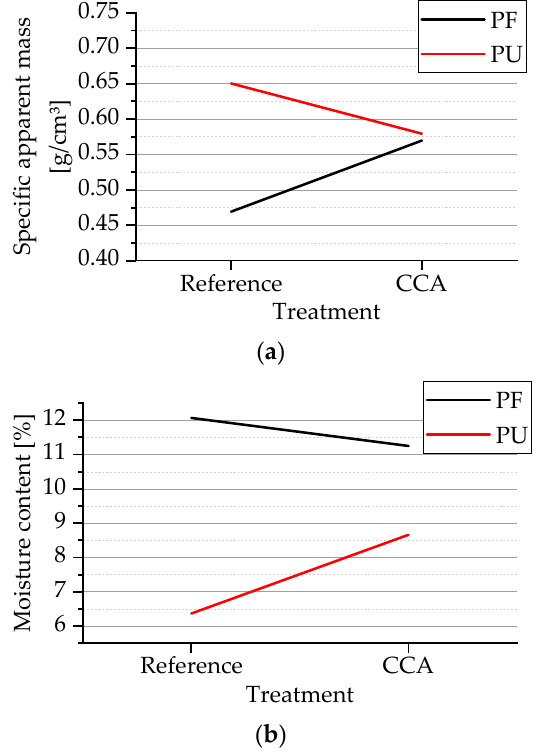
Figure 4. Interaction graphics: ( a ) specific apparent mass and ( b ) moisture content.